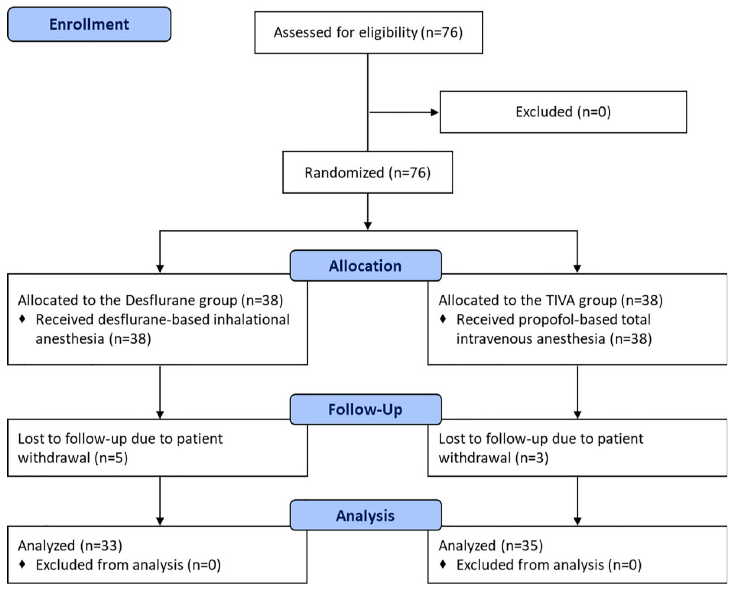
Fig 1. CONSORT flowchart of patient sample selection.